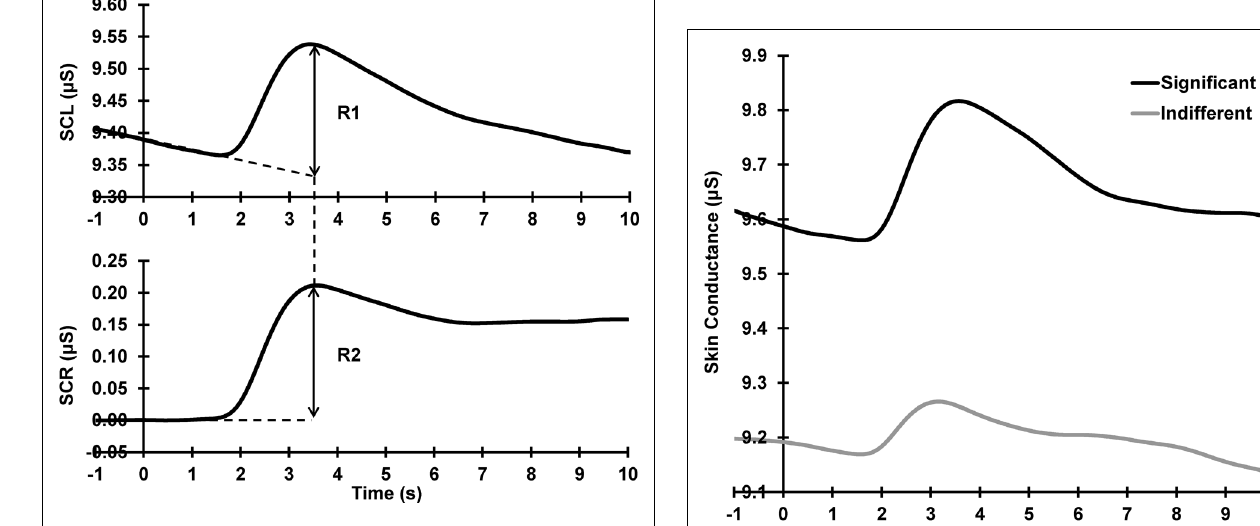
FIGURE 1 | SCR quantification procedure. Top: raw data; Bottom: after baseline-de-trending.The dashed lines at the base of the response peak represent the falling and corrected baselines, respectively.The arrows illustrate the SCR peak amplitude quantification in each. It can be seen that R1 = R2, in terms of both amplitude and peak latency.